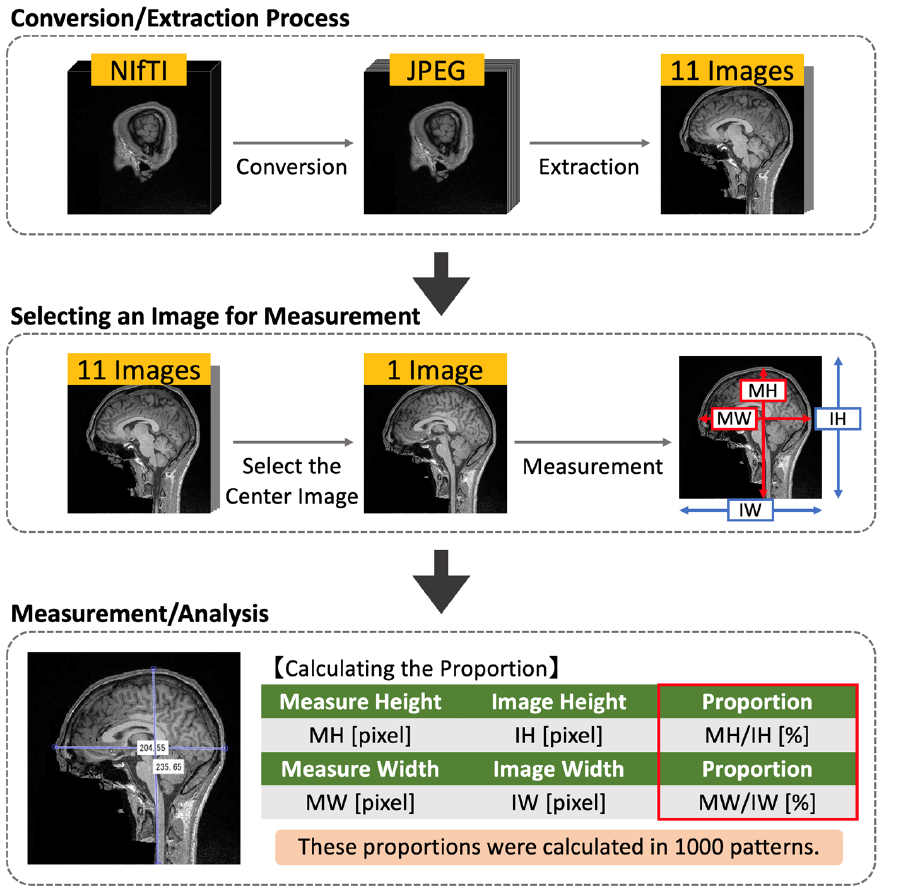
Figure 1. Measured head standard in a brain MR image. (MH: Measured Height, IH: Image Height, MW: Measured Width, IW: Image Width).